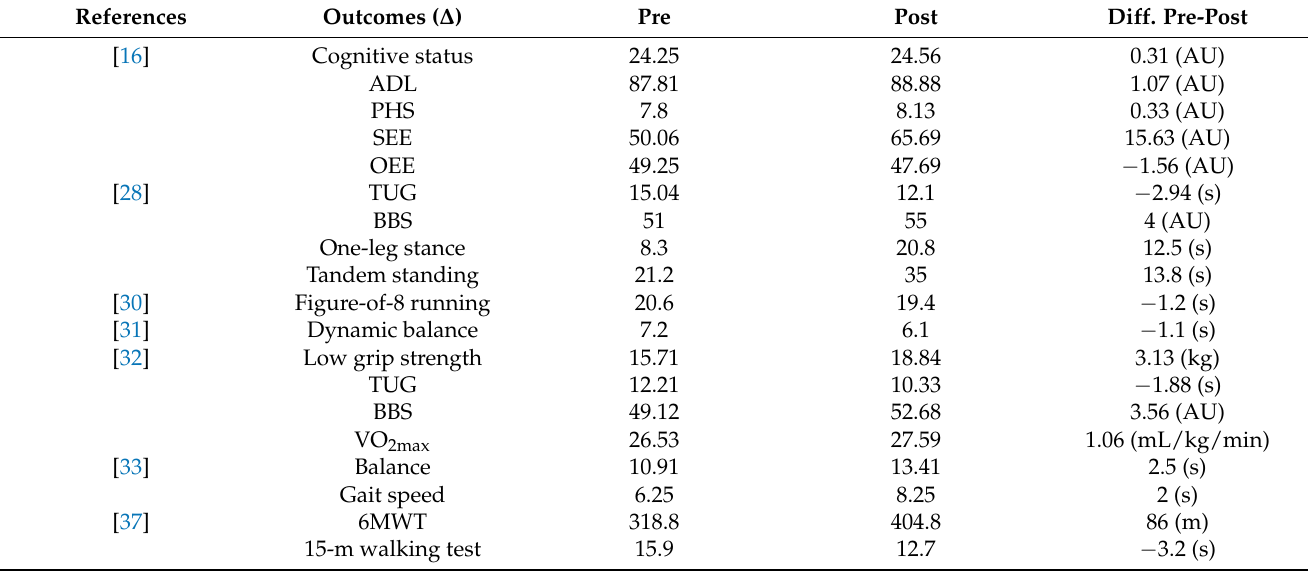
Table 2. The main outcomes before